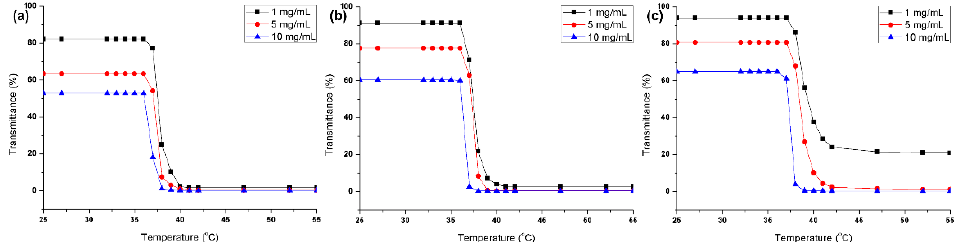
Figure 5. Temperature-dependent transmittance changes of DRBCPs in aqueous solution with varying concentration. ( a ) DRBCP1b. ( b ) DRBCP1c. ( c ) DRBCP2.